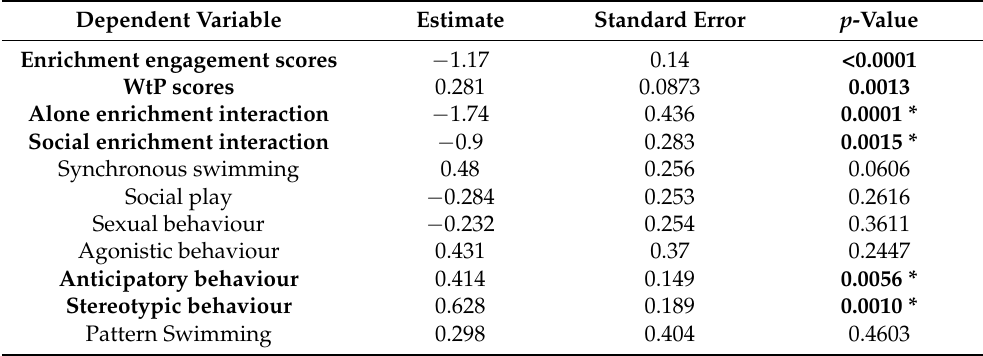
Table 3. Pairwise comparisons of model-estimated marginal means (EMMs) between non-cognitive and cognitive treatments for: enrichment engagement scores, willingness to participate (WtP) scores, and behavioural observations. Significant effects and variables are highlighted in bold; asterisks indi- cate behavioural differences remaining significant after Benjamini and Hochberg’s (1995)